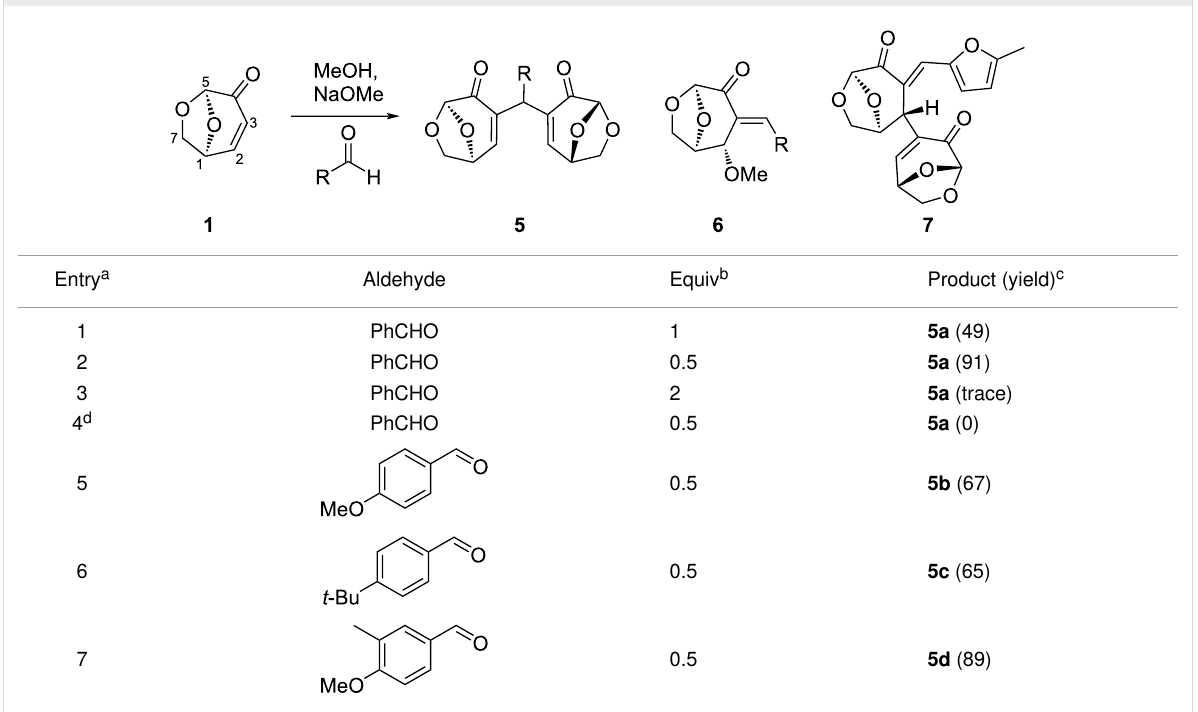
Table 1: Reactions of enone 1 and aldehydes promoted by NaOMe in MeOH.